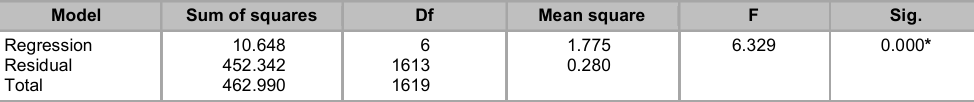
General ANOVA model: Biographical variables and total job insecurity Model Sum of squares Df Mean square F Sig. Regression